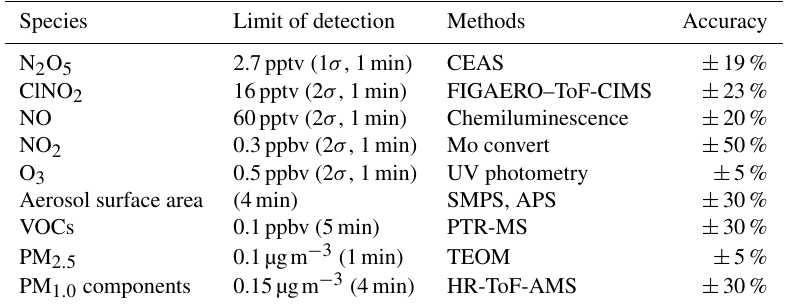
Table 1. The observed gas and particle parameters used in this analysis during the campaign.